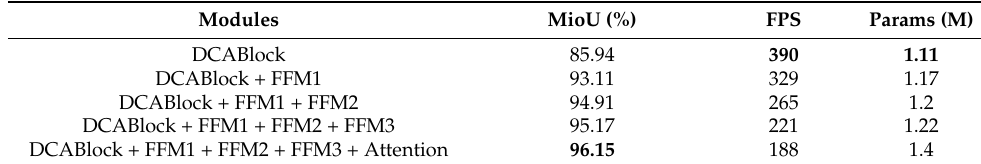
Table 1. Results of the ablation